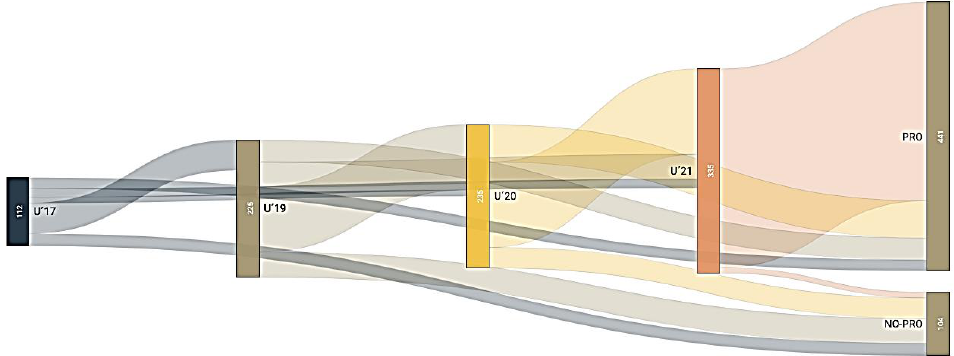
Figure 1. Players’ careers across national Figure 1. Players ’ careers across national teams.